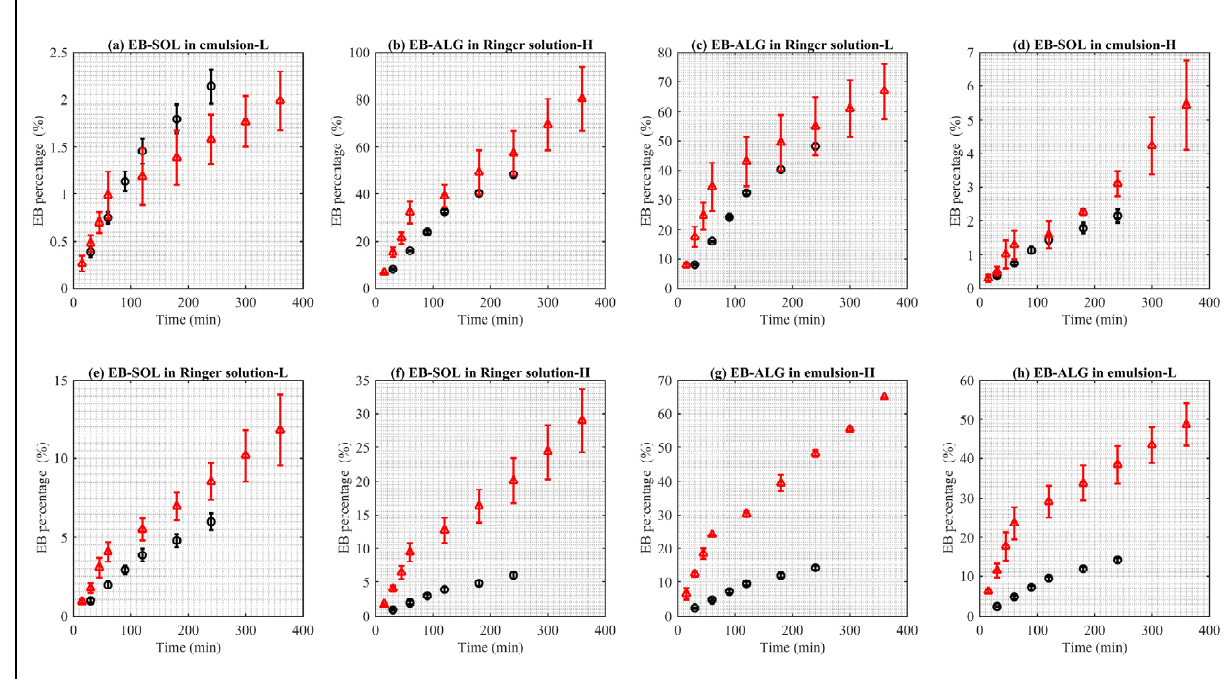
Figure 4. Comparison between the EB dissolution/permeation results in synthetic membranes (red points) and biological membranes (black points). ( a ) Represents EB–SOL in emulsion as donor media with lipophilic membrane (EM–L), ( b ) represents EB–ALG in Ringer solution as donor media with hydrophilic membrane (RS–H), ( c ) represents EB–ALG in Ringer solution as donor media with lipophilic membrane (RS–L), ( d ) represents EB–SOL in emulsion as donor media with hydrophilic membrane (EM–H), ( e ) represents EB–SOL in Ringer solution as donor media with lipophilic membrane (RS–L), ( f ) represents EB–SOL in Ringer solution as donor media with hydrophilic membrane (RS–H), ( g ) represents EB–ALG in emulsion as donor media with hydrophilic membrane (EM–H), and ( h ) represents EB–ALG in emulsion as donor media with lipophilic membrane (EM–L). Values represent the mean with standard deviation, n = 3 for FDC, and n = 5 for UCh. The release rate constant (k) indicates the rate at which EB crosses the membrane, while the Korsmeyer–Peppas release exponent (n) indicates the release mechanism, through either Fickian or non-Fickian diffusion. In non-Fickian diffusion, there are the following mechanisms: anomalous transport, Case I transport, and Super Case II transport [20].